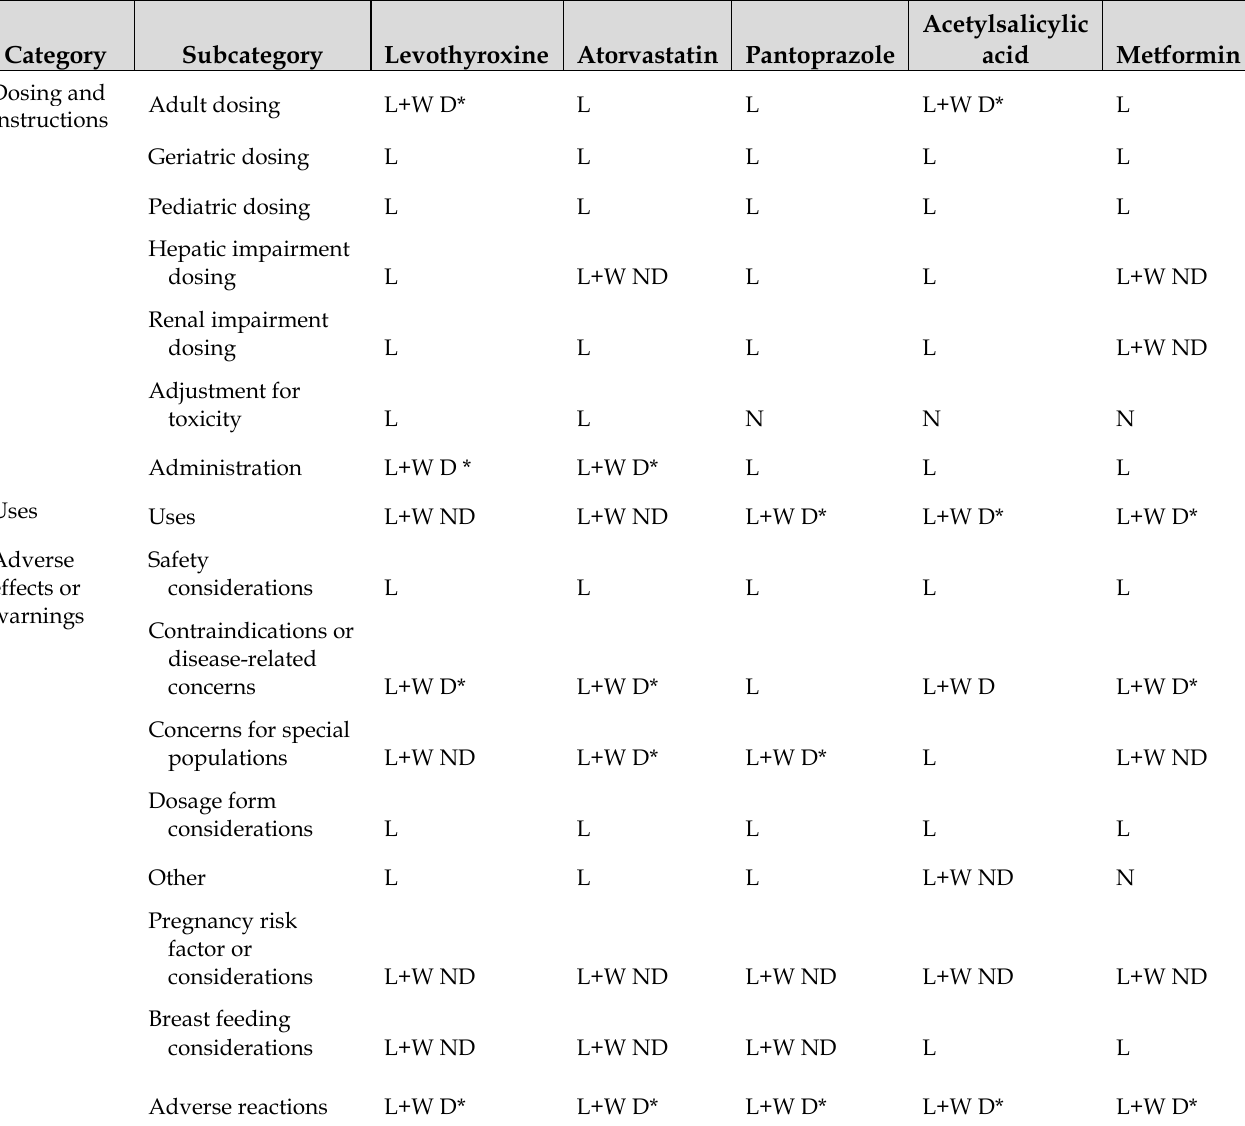
Table 1 Subcategory content comparison for Lexicomp and Wikipedia medication information